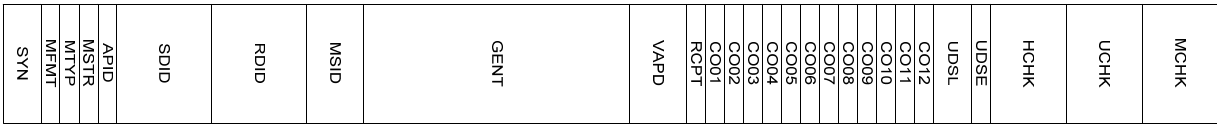
Figure 3. Field positions in the Protocol